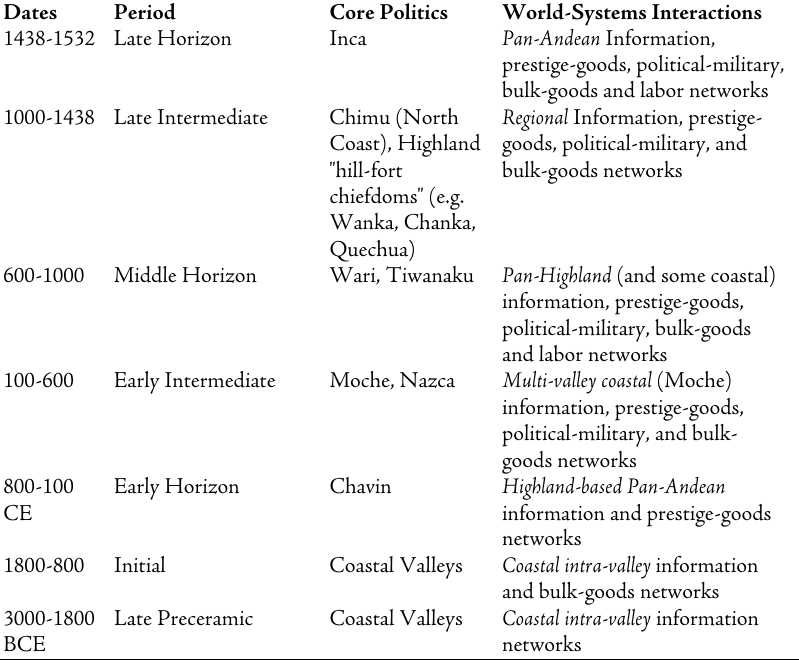
Table 1 – A Synoptic Chronology for the Central